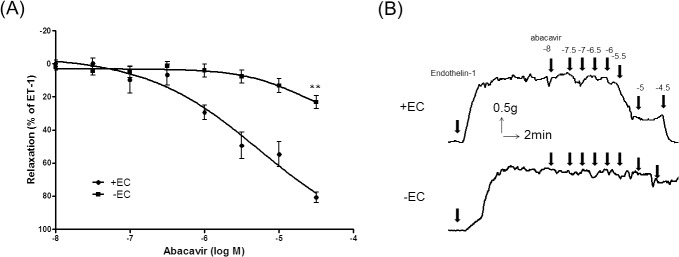
Effect of abacavir on the relaxation of rat basilar arteries.Abacavir-induced relaxation of rat basilar arteries was measured in the presence (+EC) or absence (–EC) of endothelial cells. (A) Changes in tension were expressed as the percentage decrease in response to contraction caused by endothelin-1 (ET-1; 1–10 nM). (B) Sample trace showing the effect of endothelium removal on abacavir-induced relaxation. Values are means ± S.E.M of six to eight sets of experiments and statistical comparisons were made using ANOVA. ** P<0.01 compared with control.